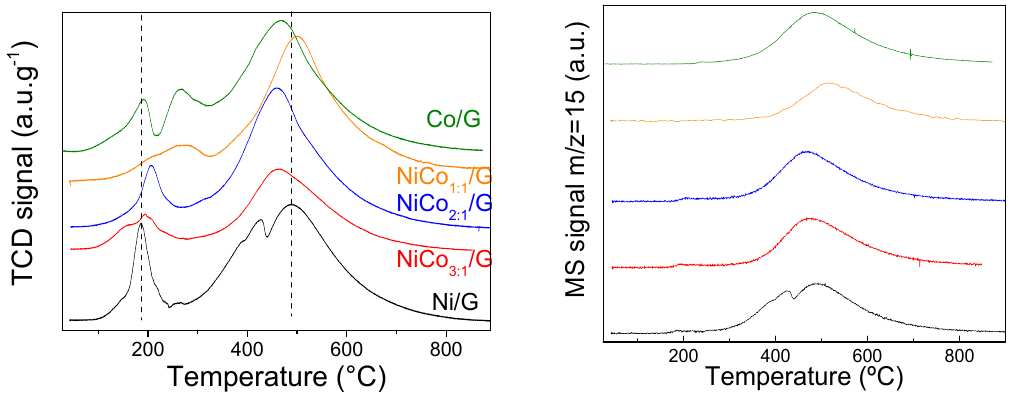
Figure 4. TCD profile ( left ) and MS signal of the m / z = 15 fragment ( right ) obtained for all the catalysts during the temperature programmed reduction (TPR).